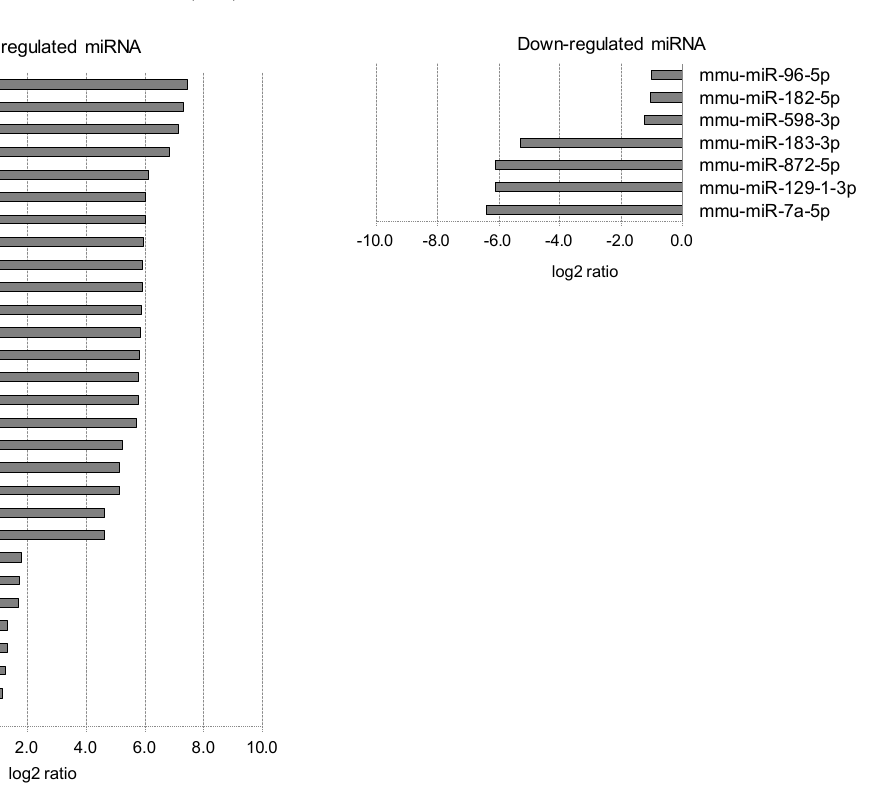
Figure 8. Retinal pigment epithelium (RPE)/choroidal miRNAs affected by myopia induction. The RPE/choroidal miRNAs whose expression was affected by myopia induction are listed as upregulated ( left ) and downregulated ( right ).